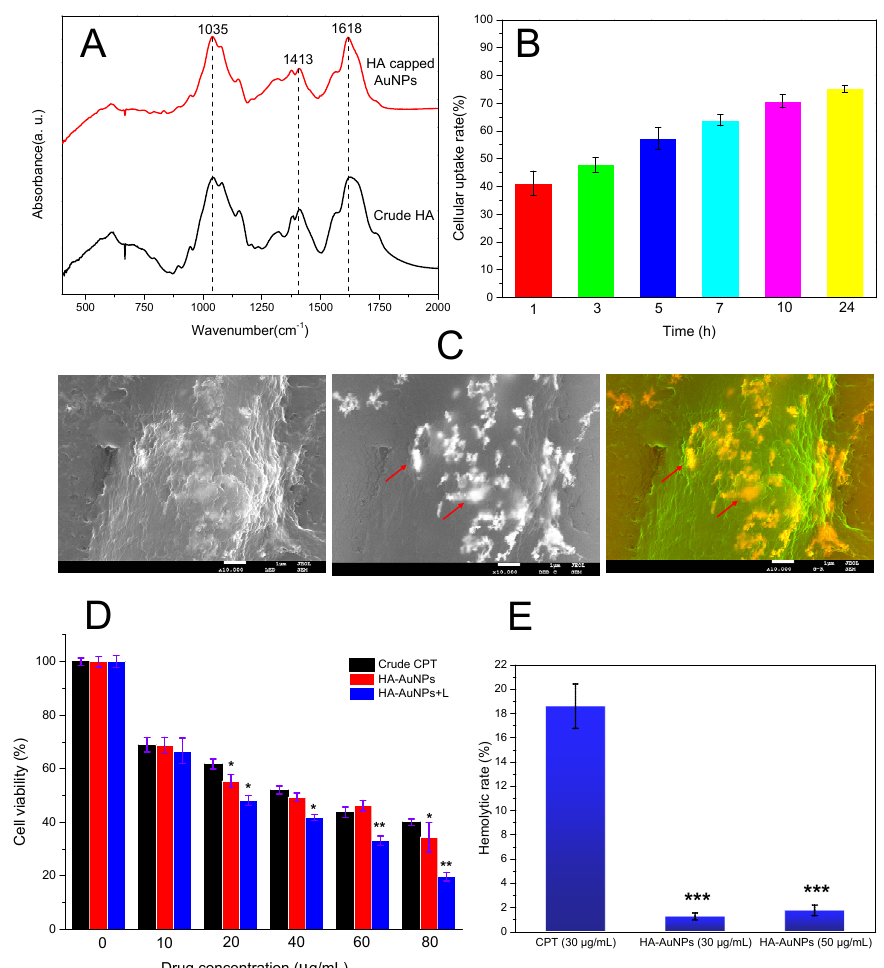
Figure 3. ( A ) FTIR absorption spectra of HA-capped AuNPs together with crude HA powder. ( B ) Cellular uptake efficiency of HA-capped AuNPs (Conc. =20 µ g/mL) at different incubation time in MDA-MB-231 cells. ( C ) Representative SEM images showing the intracellular AuNPs in MDA-MB-231 cells after 24 h incubation, arrows emphasize the existence of AuNPs aggregates inside the cells. ( D ) Inhibitory effect of different drugs at various concentration against bulk MDA-MB-231 cells. ( E ) Hemolytic effect of HA-capped AuNPs or CPT under different working concentrations, reflecting their respective hemocompatibility. * p < 0.05, ** p < 0.01 and *** p < 0.001 vs. CPT group.